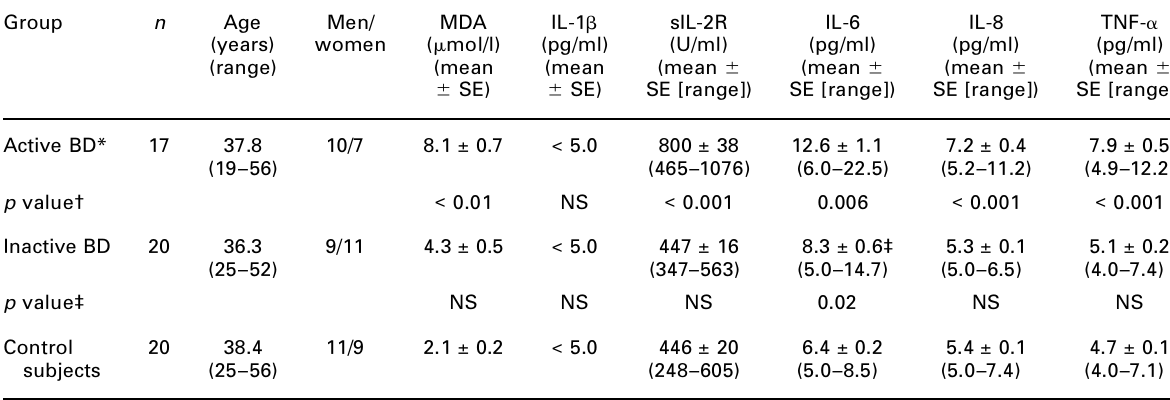
Table 2. MDA, TNF- a , IL-1 b , sIL-2R, IL-6 and IL-8 levels in patients with Behçet’s disease and control subjects, and the relation with disease activity Group